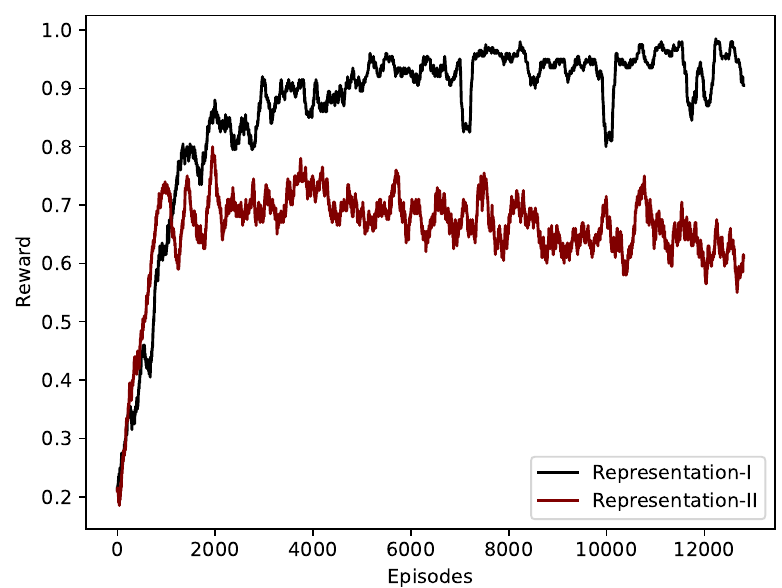
Figure 6. Convergence of the MADRL agent during the training of both networks simultaneously.